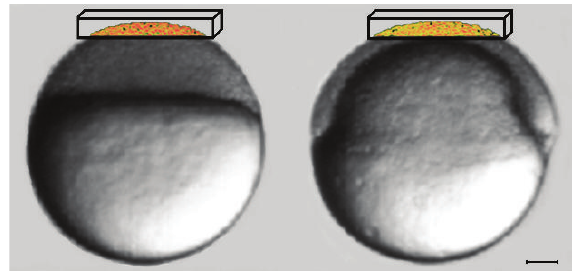
Figure 1: Zebrafish embryo. Scalar bar is 100 μ m. The imaged volume is represented in volume rendering inside the black box. Left: embryo at 3.5 hours post fertilization (sphere stage). Right: embryo at 7.5-hour postfertilization (shield